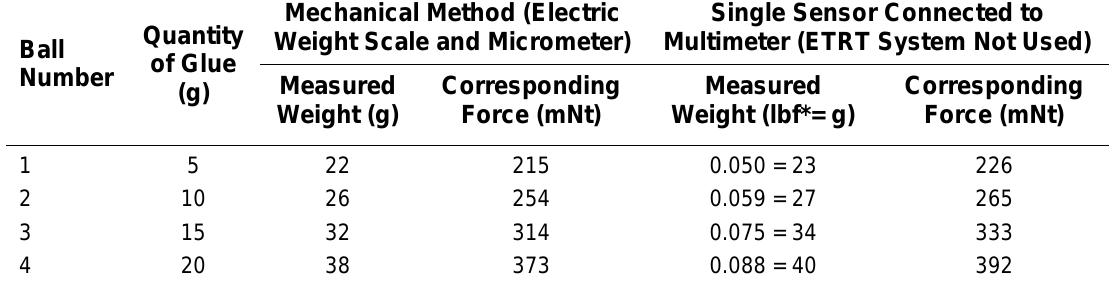
Testing Rigidity of Phantom Balls Injected with Glue using a Mechanical Method (Independent Method), and a Single Sensor and Multimeter (Test of Tactile Sensor)